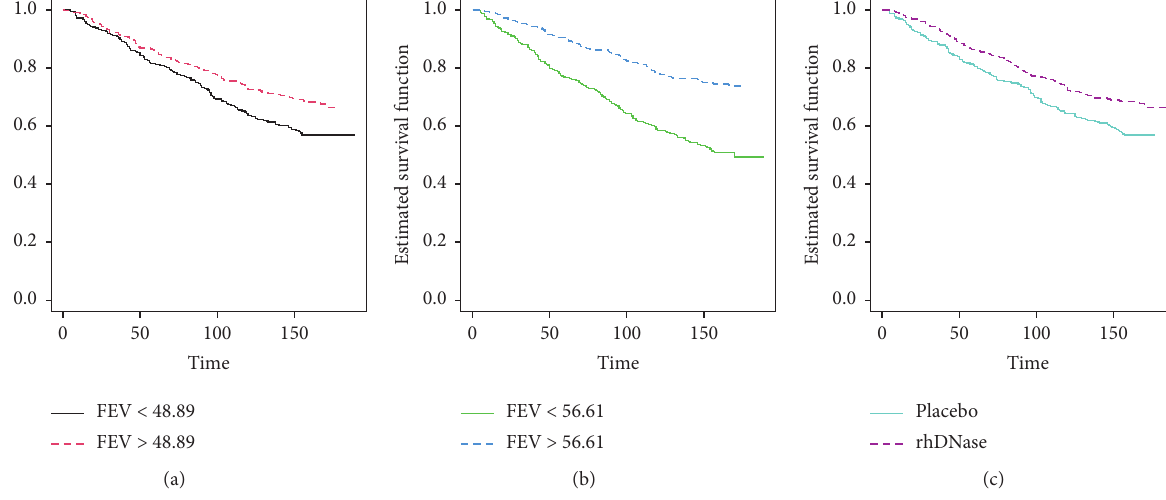
Figure 1: Estimated Kaplan–Meier survival curves for patients in pulmonary exacerbations study: (a) under different expiratory volumes; (b) under different adjusted expiratory volumes; (c) under different treatment